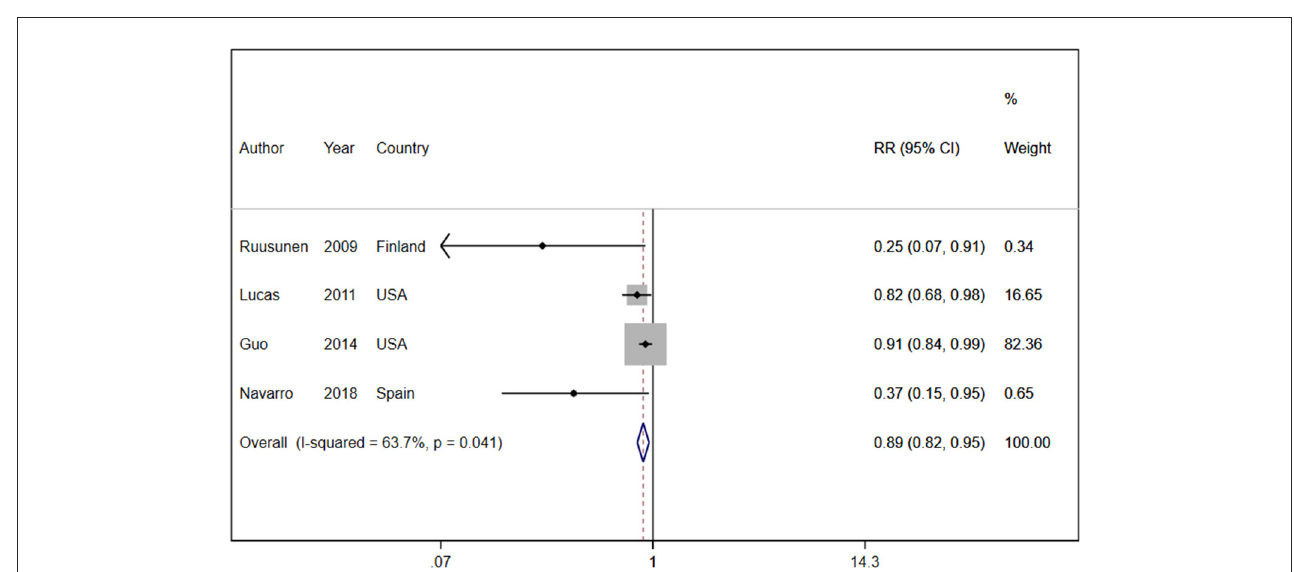
FIGURE1 Relative risk of depressive symptoms for the highest compared with the lowest category of coffee intake. RR, relative